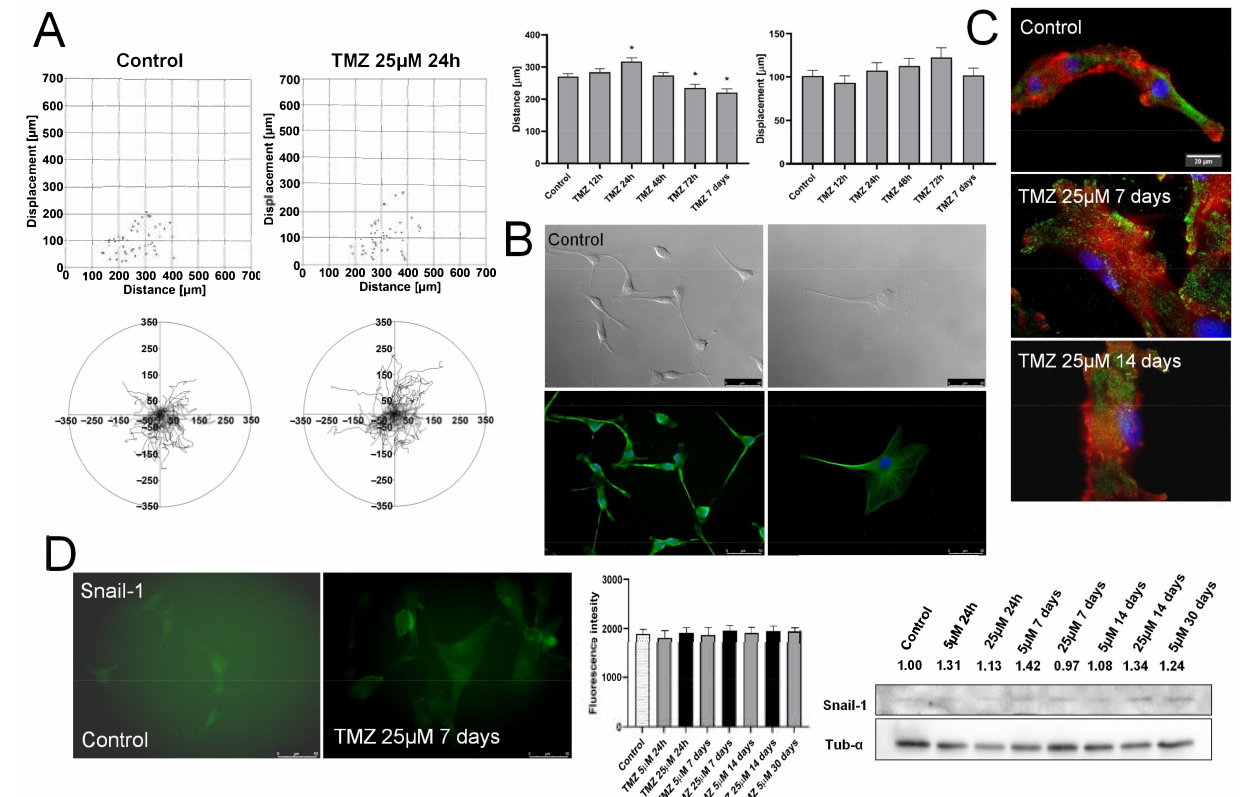
Figure 2. Effect of TMZ stress on the invasiveness of U87 cells. ( A ) U87 cells were seeded at the density of 2000/well of 12-well plate and incubated for 24 h before the administration of TMZ. Their motility was estimated with time-lapse video microscopy at the indicated time-points. Circular diagrams, dot-plots (for the data from the long-term TMZ treatment, see Figure S2A) and bar graphs show trajectories, movement parameters (distance and displacement) at the single cell and population level, respectively. ( B ) Cells were incubated in the presence of 25 µ M TMZ, fixed, permeabilized and stained against α -tubulin (green)/DNA (blue) to visualize cell morphology/microtubular architecture at the indicated time-points. (cf. Figure S2B). Scale bar 50 µ m. ( C ) U87 cells were incubated in the presence of 25 µ M TMZ for 7/14 days and stained against vinculin (green)/actin (red)/DNA (blue). Scale bar 20 µ m. ( D ) Effect of TMZ on the expression levels of Snail-1 in U87 populations. Snail-1 levels were then estimated with microscopy-assisted fluorimetry (left panel) and immunoblotting (right panel, cf. Figure S2C). Scale bar 50 µ m. Numerical data show the density of Snail-1-specific bands intensity calculated against the levels of α -tubulin as the housekeeping gene. Statistical significance was calculated with ANOVA/non-parametric Mann–Whitney test, * p < 0.05 vs. control. Data representative for three independent experiments. Note that TMZ stress only transiently increases the invasiveness of U87